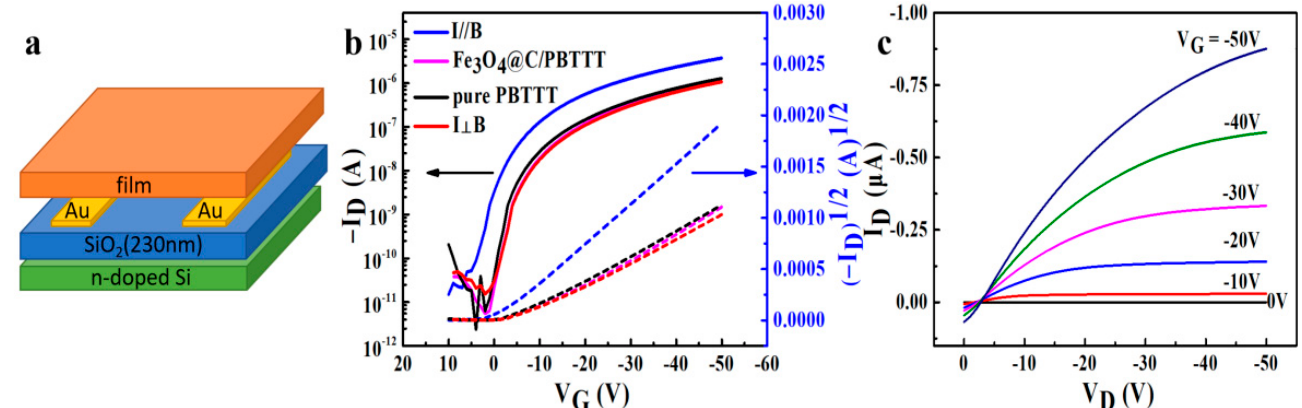
Figure 4. ( a ) Illustration of bottom-gate/bottom-contact (BG/BC) OFET device configuration; ( b ) Typical transfer characteristics for the BG/BC OFETs employing the magnetically aligned Fe 3 O 4 @C/PBTTT composite film as well as unaligned spin-coated pure PBTTT film (black line) and spin-coated Fe 3 O 4 @C/PBTTT composite film (pink line). The channel current is parallel (I ∥ B) (blue line) and perpendicular (I ⊥ B) (red line) to the magnetic field direction. ( c ) Typical output curves of the BG/BC parallel device.